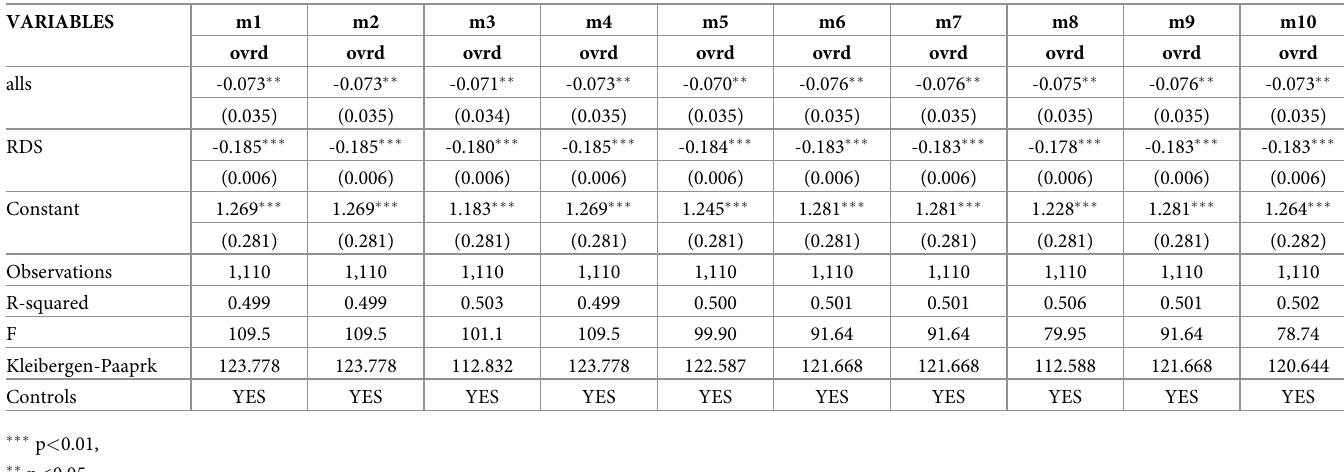
Table 4. Regression results of the first